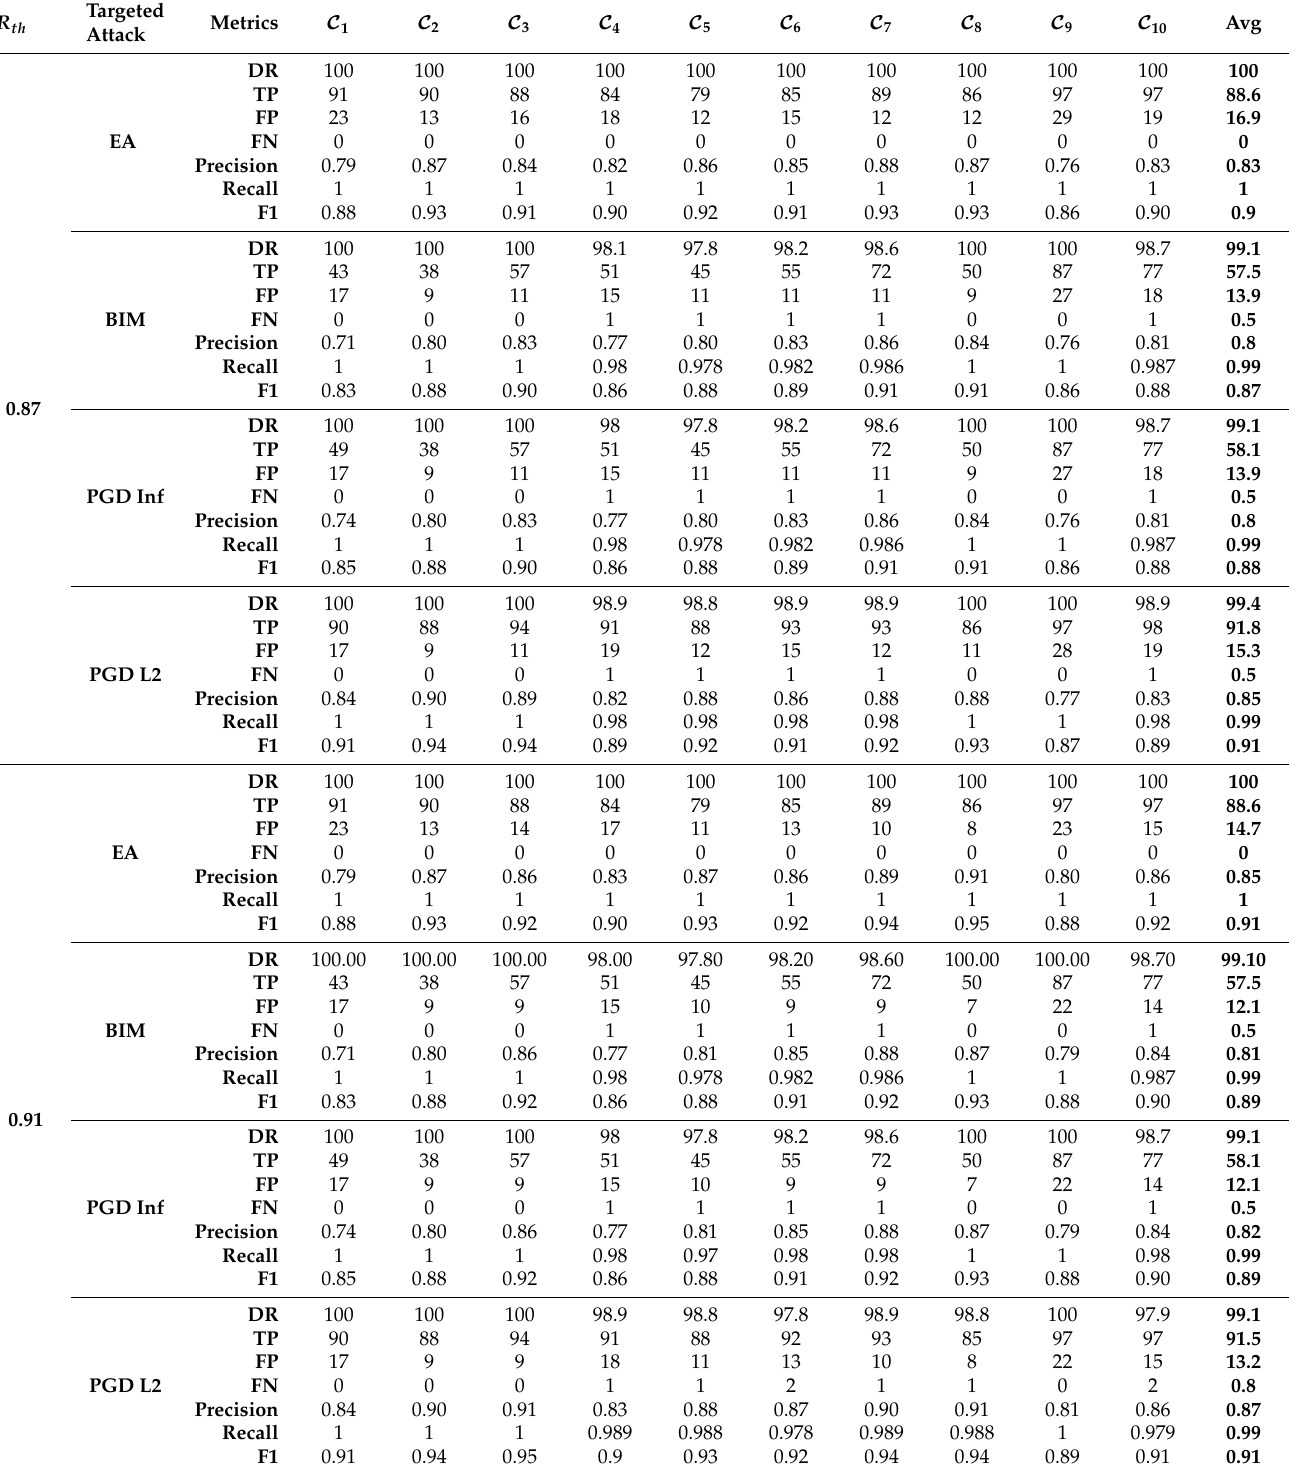
Table 10. Targeted attacks—DR as a percentage, and TP, FP, FN, precision, recall, F1 scores per CNN per attack for each selected value of R th = 0.87 and 0.91, and their corresponding